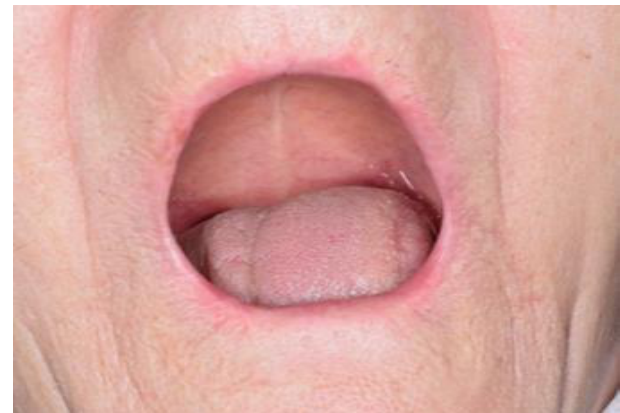
Fig. 1. Patient’s mouth opening (26mm).